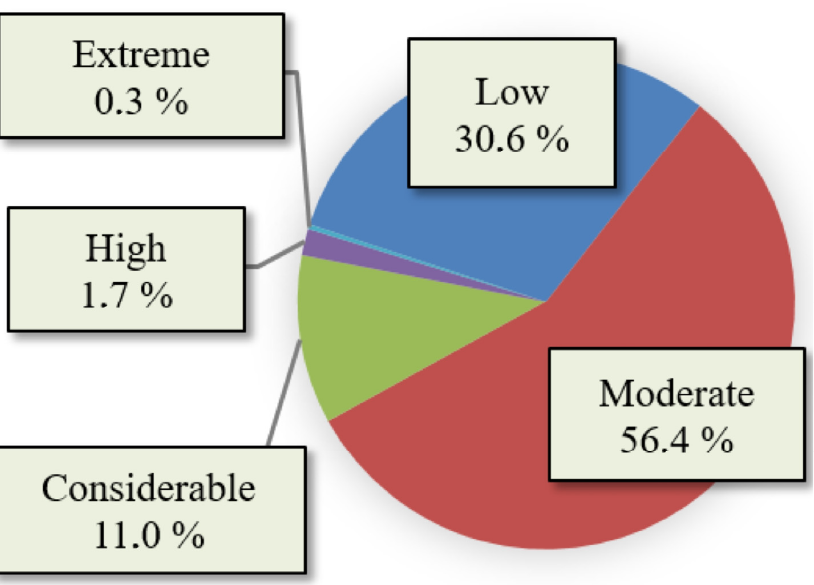
Figure 6. Frequency of days with different avalanche danger levels.